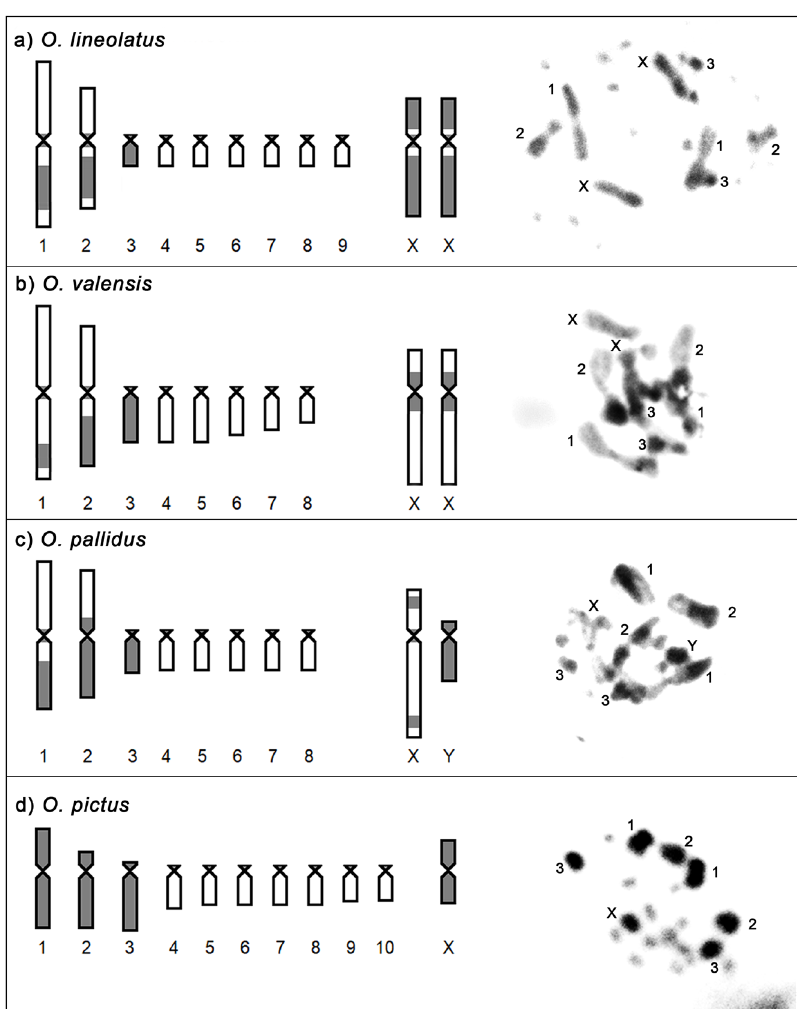
Figure 3 – Identification of C-banding markers (gray) in mitotic metaphase of females of (a) Oecanthus lineolatus and (b) O. valensis , and males of (c) O. pallidus and (d) O. pictus . Indication of chromosome pairs with C-banding markers. Scale bar = 10